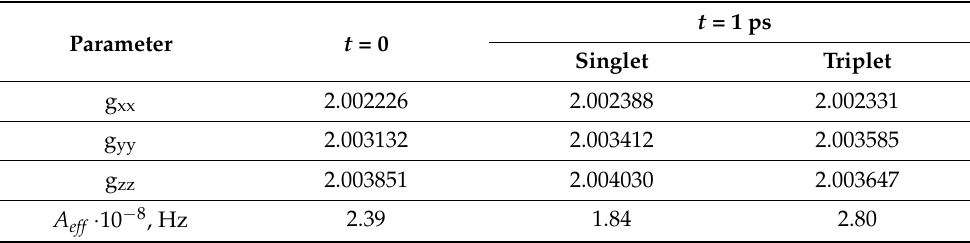
Table 1. C · (CN) radicals of singlet and triplet AIBN molecules at minimum energy and after 1000 fs of molecular dynamic